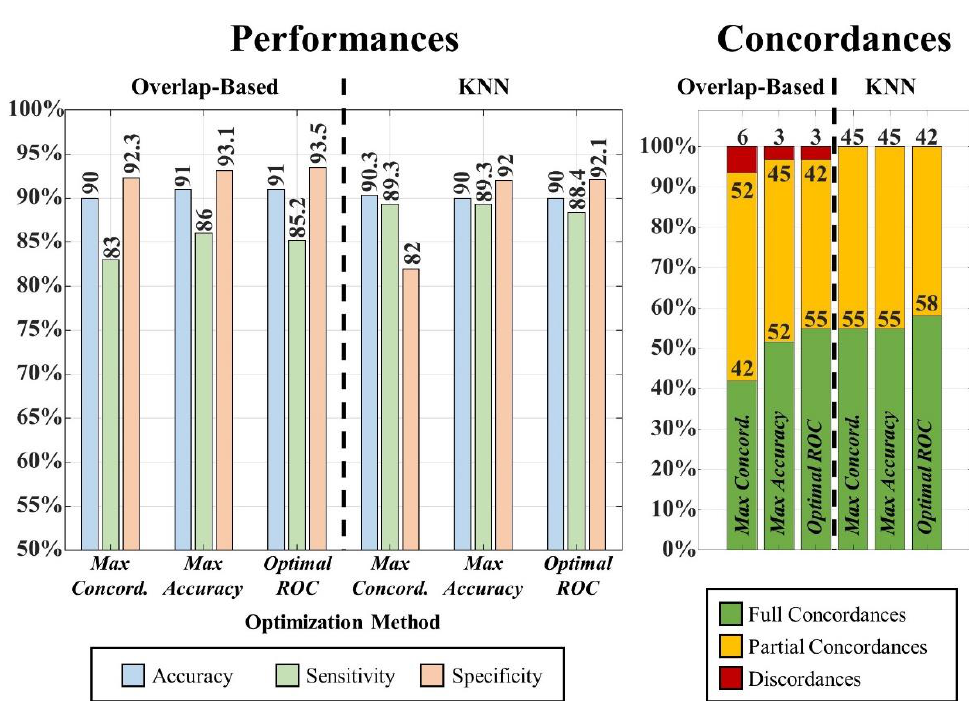
Figure 6. Anatomical report results. Overall performances (left bar plot) and individual reports’ concordance (right bar plot) for overlap-based (left) and KNN-label-substitution (right) approach-